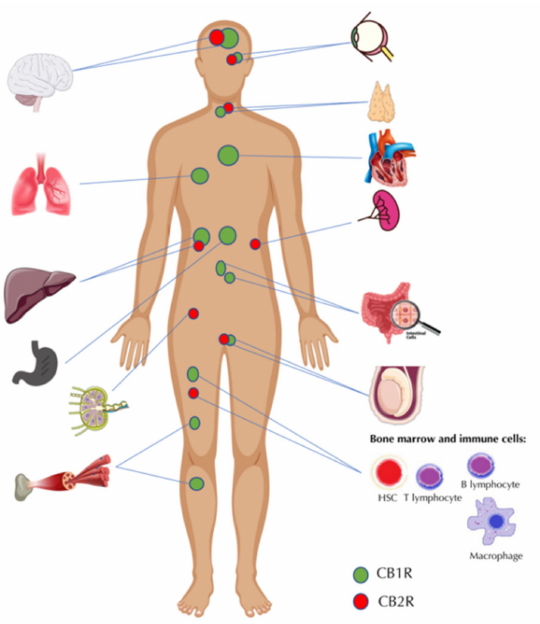
Figure 1. The distribution of cannabinoid receptors within the human body. CB1R—cannabinoid receptor type 1, CB2R—cannabinoid receptor type 2, HSC—hematopoietic stem cell (some graphic was acquired from vecteezy.com, accessed date: 1 November